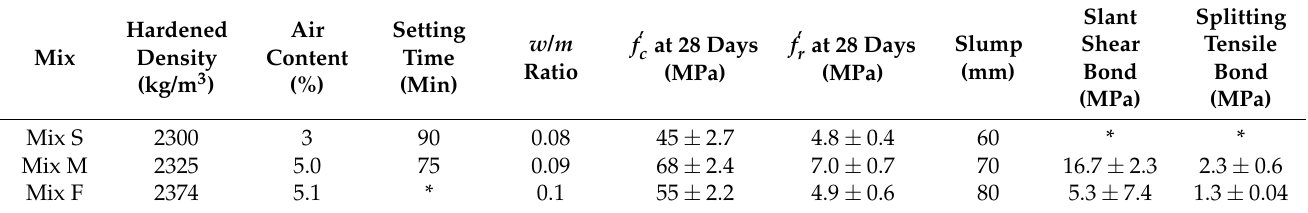
Table 2. Fresh and hardened properties of parent and repair mixes.